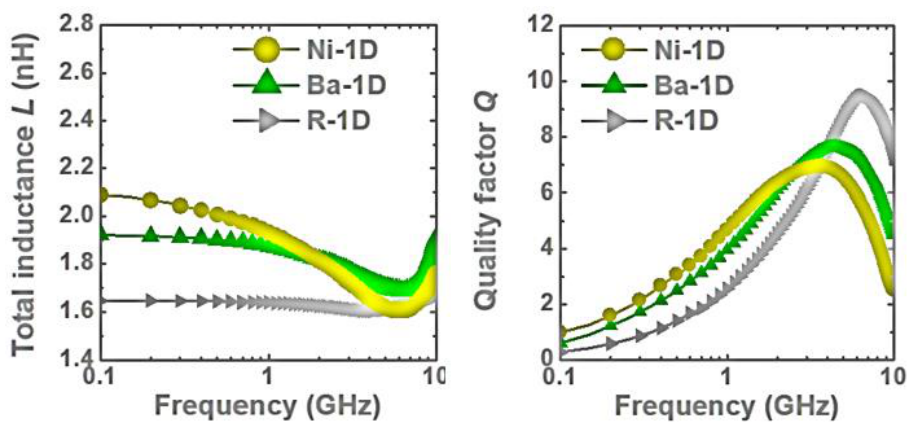
Figure 3. Measured L and Q for ferrite-partially-filled inductor prototypes: ( Left ) total L shows significant improvement for Ni-Zn-Cu sample at 0.1 – 5 GHz and Co 2 Z-type sample at 0.1 – 10 GHz over the air-cored references, and ( Right ) Q-factor shows significant improvements for Ni-Zn-Cu device at 0.1 – 3.5 GHz and Co 2 Z-type device at 0.1 – 4 GHz over the reference [16].